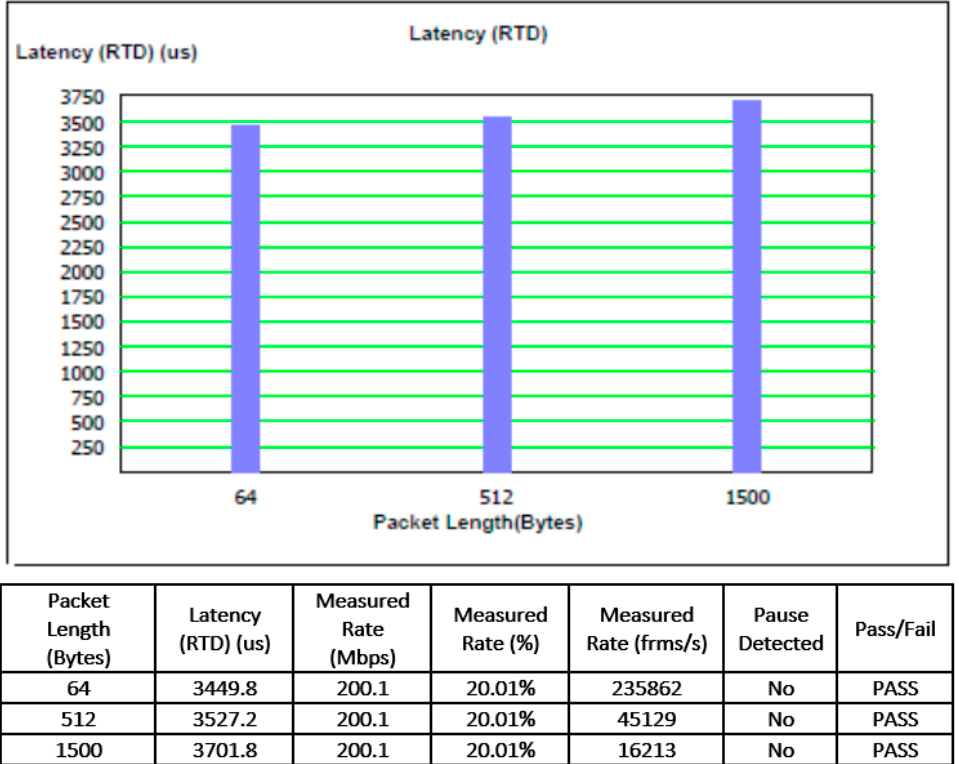
Figure 19. Latency.